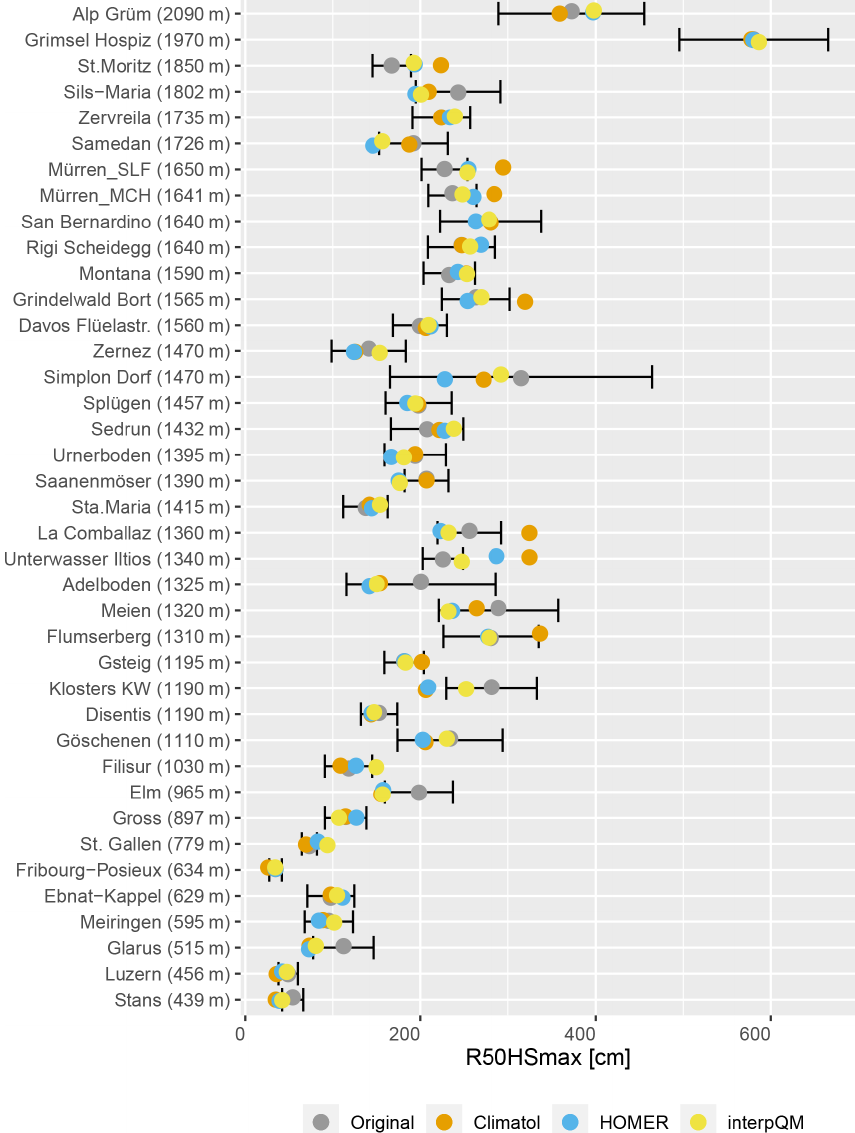
Figure 6. HSmax with 50-year return periods and 95% confidence intervals for both original (grey) and homogenised data using Climatol (orange), HOMER (blue), and interpQM (yellow). The whiskers represent the 95% confidence interval for the original values. Stations are ordered according to